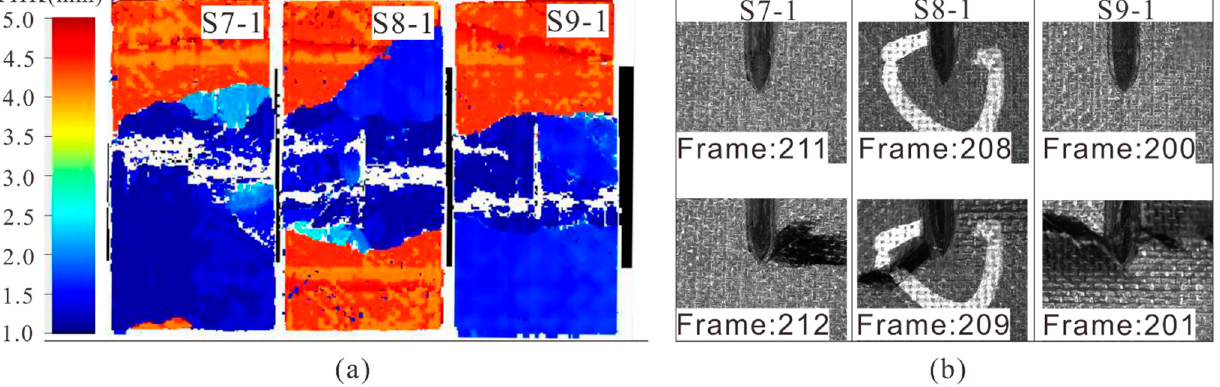
Figure 9. ( a ) C-scan results and ( b ) failure modes of specimens with 0° deep cracks after compression.